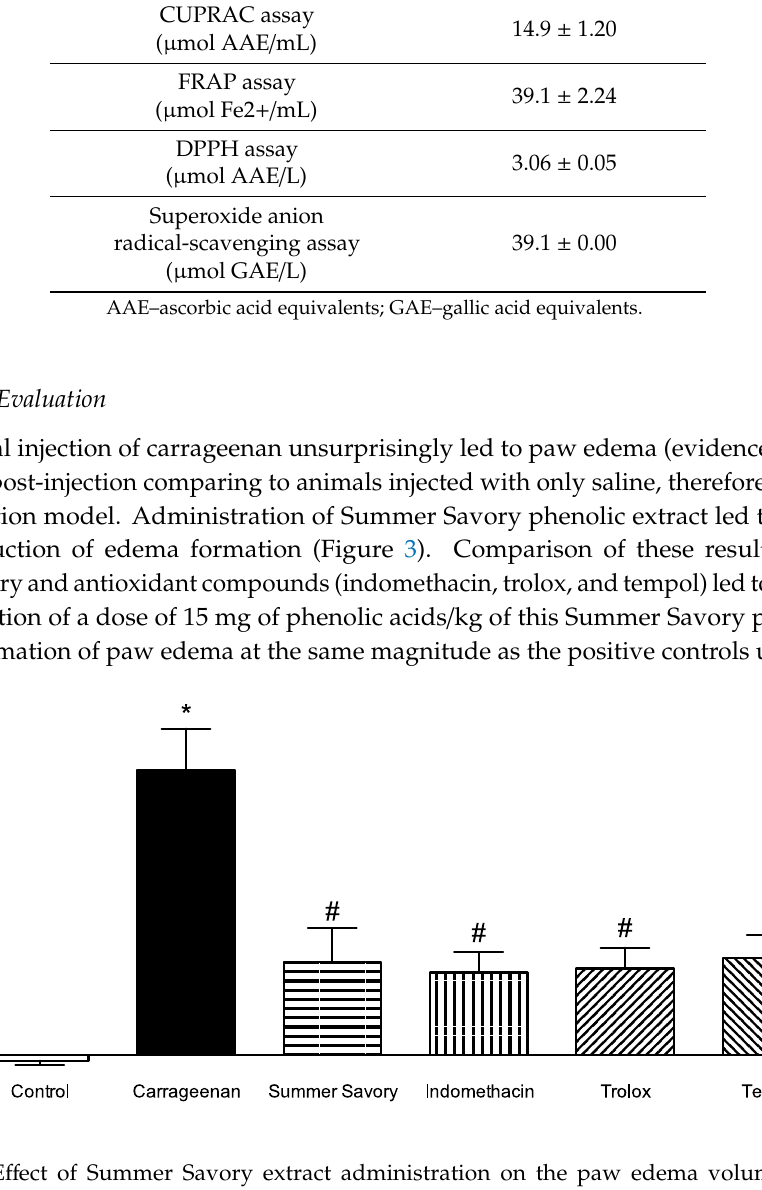
Figure 3. Effect of Summer Savory extract administration on the paw edema volume induced by carrageenan. * p < 0.001 vs. Control; # p < 0.001 vs. Carrageenan. Control group ( n = 8); Carrageenan Group ( n = 8); Summer Savory ( n = 8); Indomethacin ( n = 8); Trolox ( n = 8); Tempol ( n =